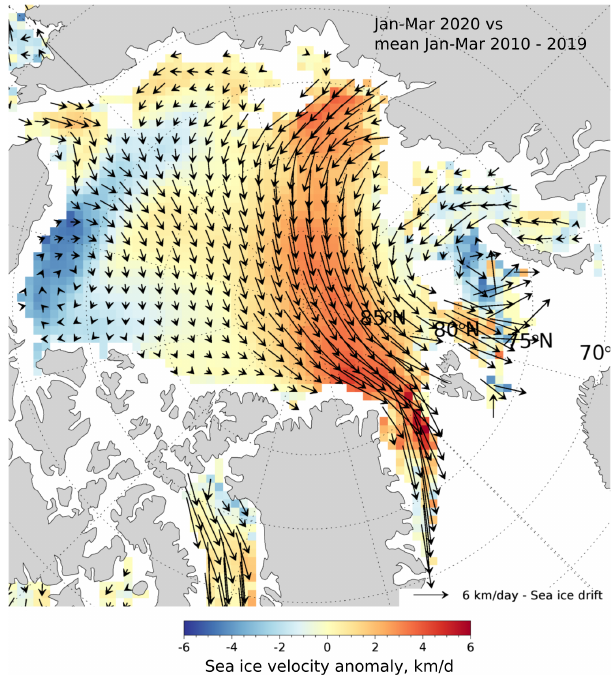
Figure 5. The 3-month (January–March) sea ice velocity anomalies in 2020 with respect to the reference period 2010–2019. Anoma- lies were computed from the OSI-405-c motion product provided by the Ocean and Sea Ice Satellite Application Facility (OSI SAF; Lavergne, 2016). The vectors plotted on top indicate the average daily sea ice motion for the same period (reprinted from Dethloff et al.,